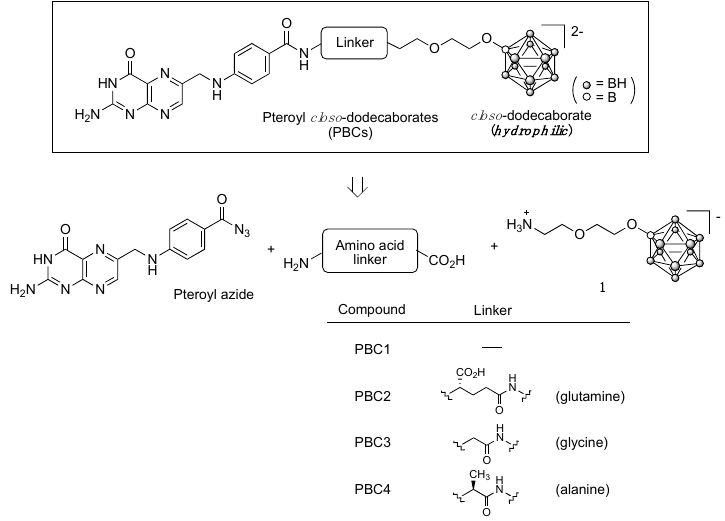
Figure 1. Structures and synthetic strategy of water-soluble pteroyl closo -dodecaborates (PBCs1-4).